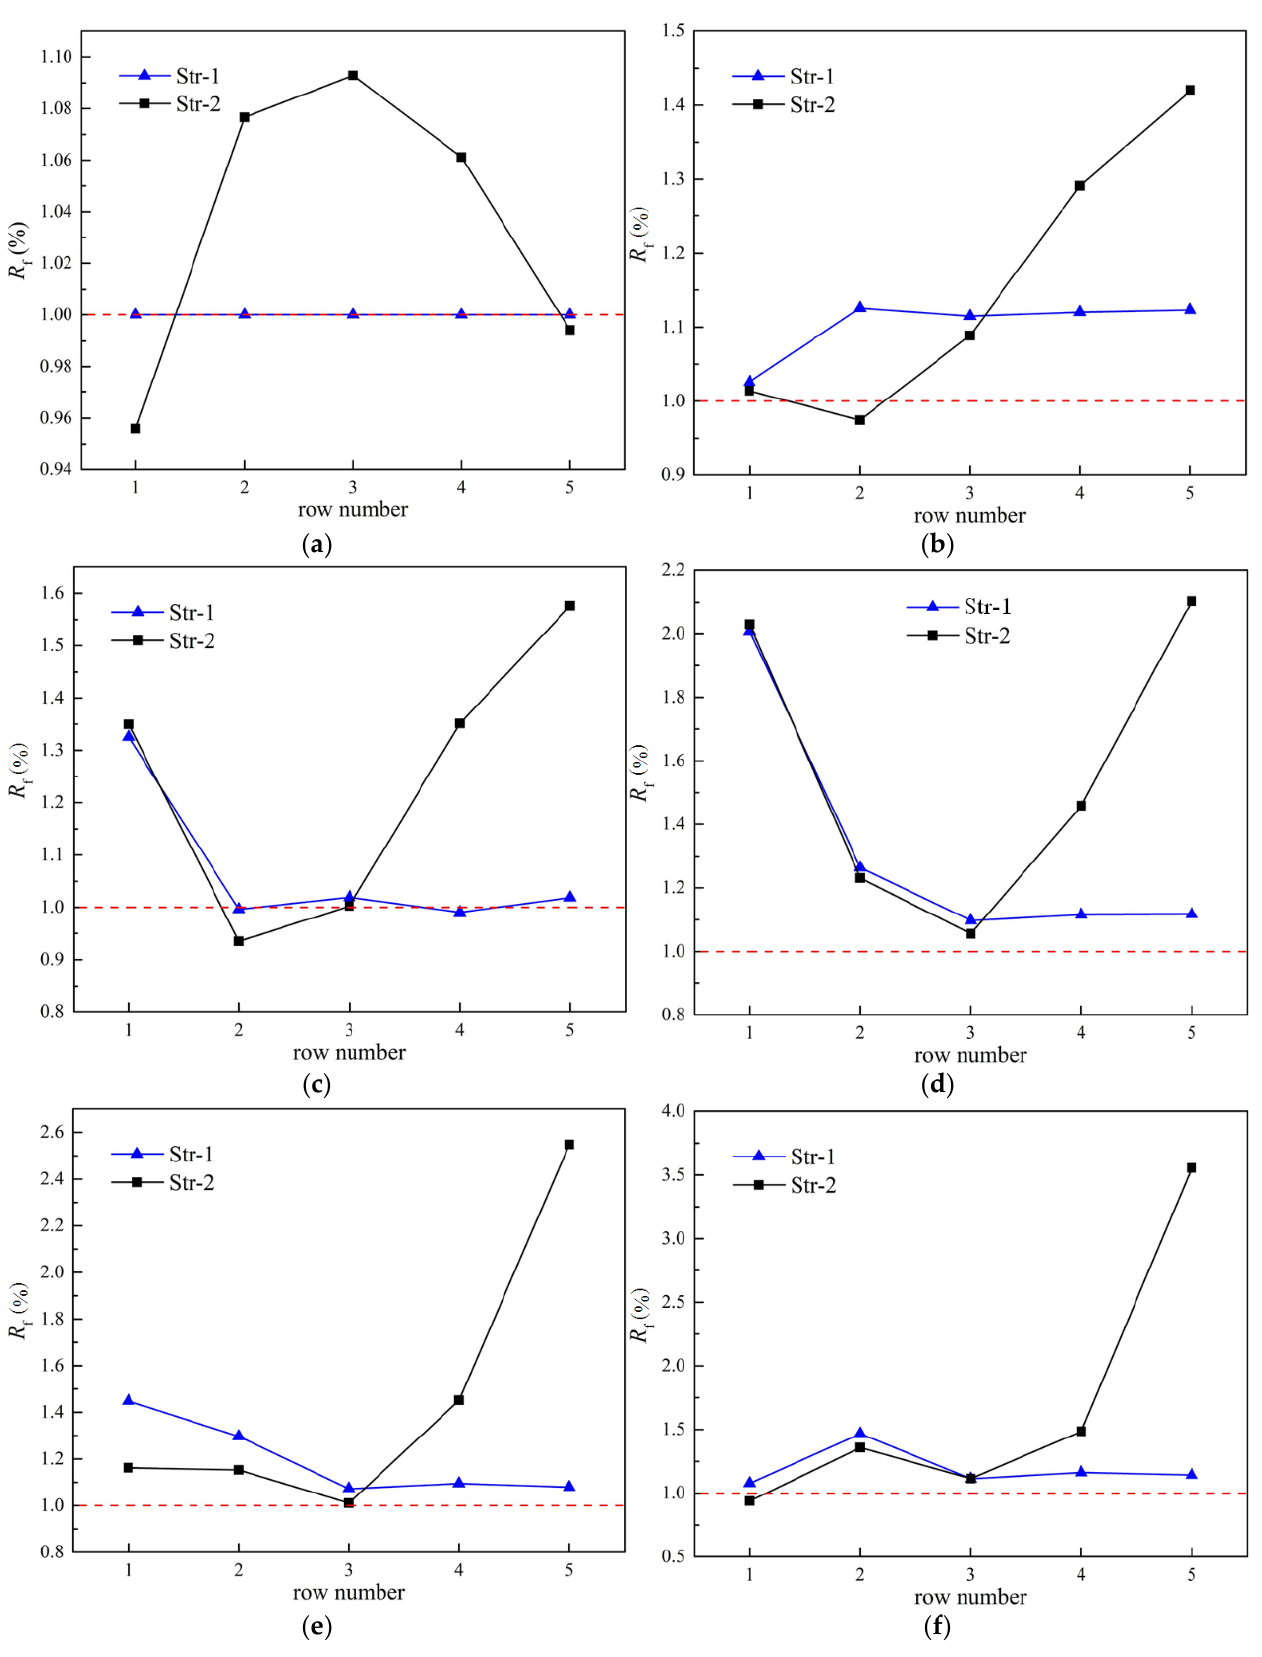
Figure 15. Cost-effectiveness of the fans in each row for Str-1 and Str-2 cases under various ambient conditions: ( a ) no wind; ( b ) 4 m/s; ( c ) 8 m/s; ( d ) 12 m/s; ( e ) 16 m/s; ( f ) 20 m/s. ( b ) 4 m/s; ( c ) 8 m/s; ( d ) 12 m/s; ( e ) 16 m/s; ( f ) 20